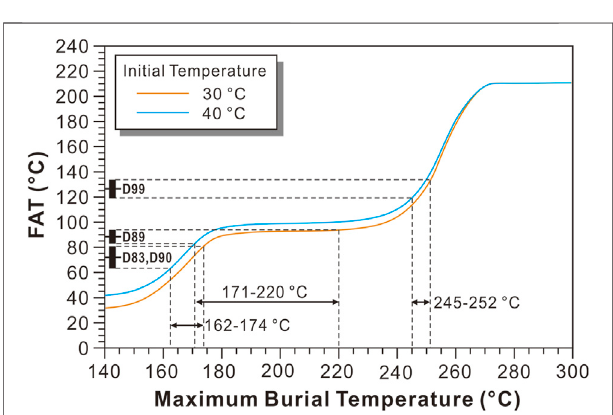
FIGURE 8 | Relationship between the fi nal apparent temperature (FAT) and the maximum burial temperature of the dolostone from the Puguang gas fi eld, assuming that the dolomite crystalized at 30 and 40 ° C at 250 Ma. The solid-state reordering model for dolomite is from Lloyd et al. (2018).